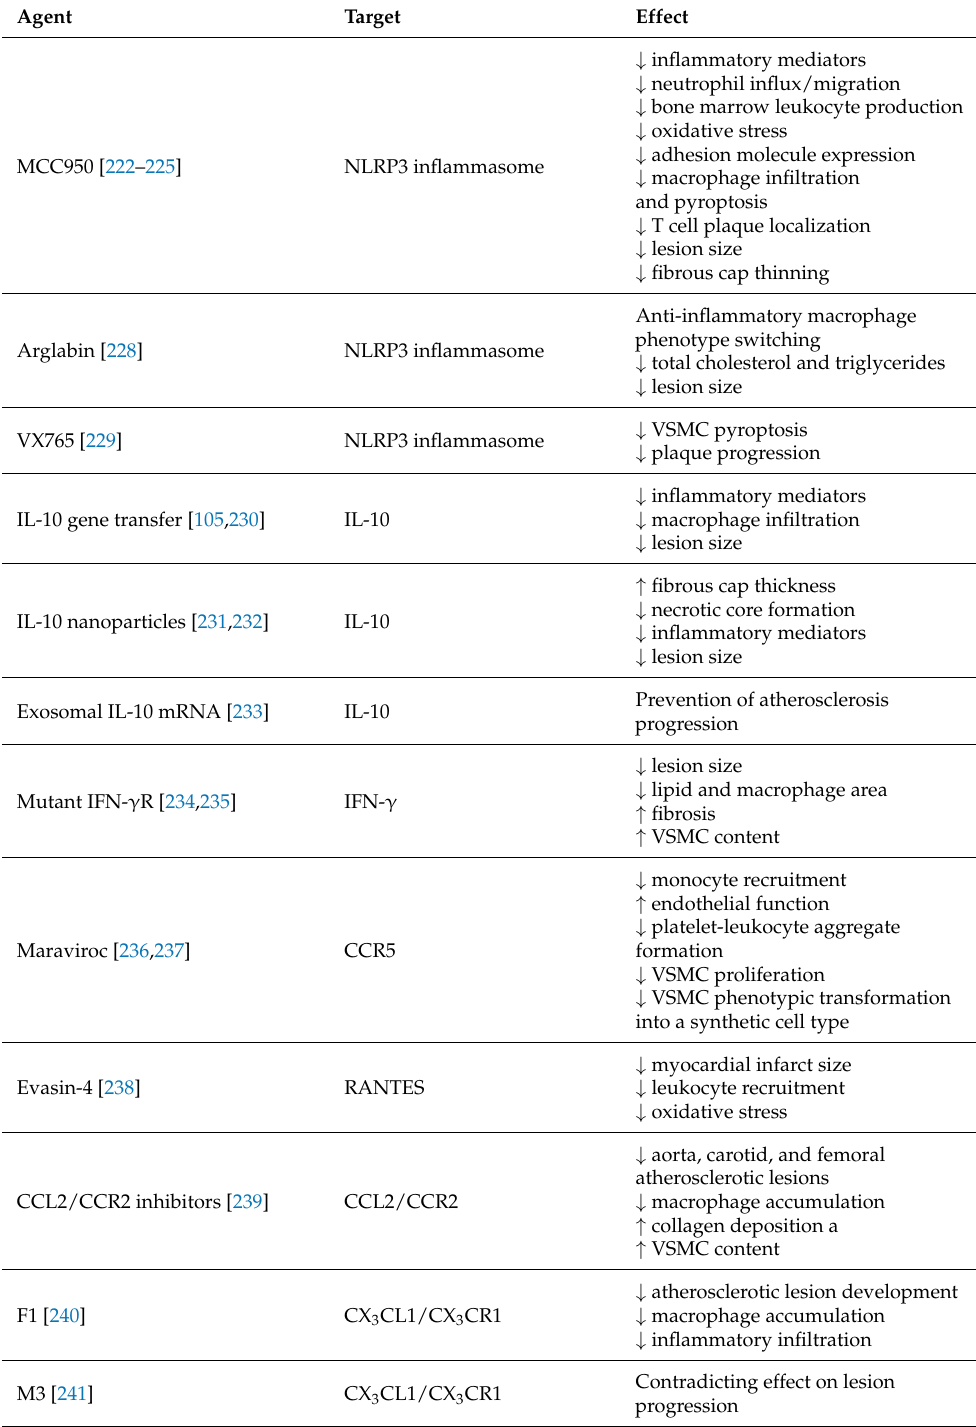
Table 2. Preclinical evidence of investigational cytokine-based therapies in